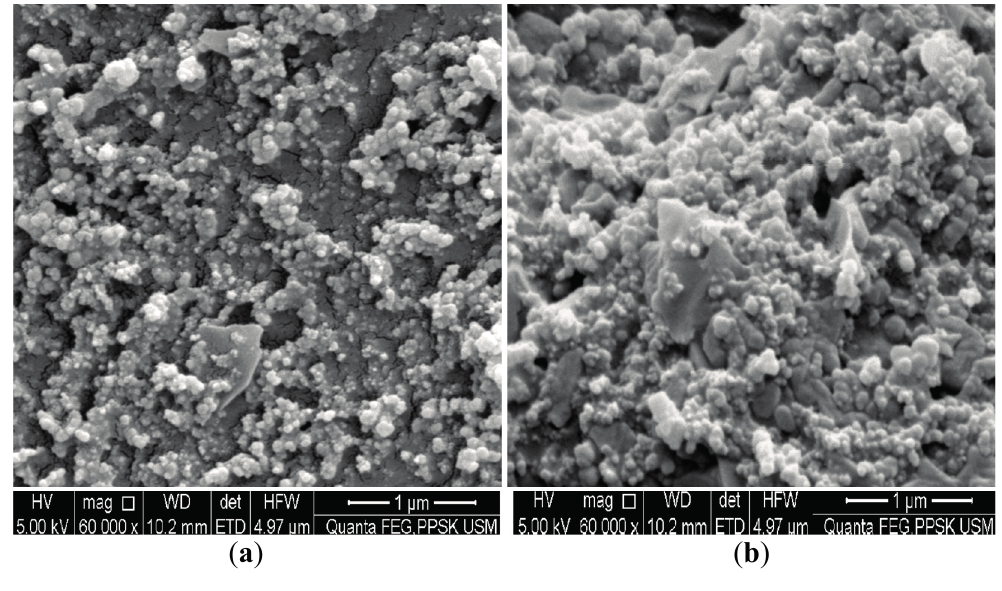
Figure 2. SEM surface images of ( a ) bare carbon electrode and ( b ) carbon electrode modified with antibody.